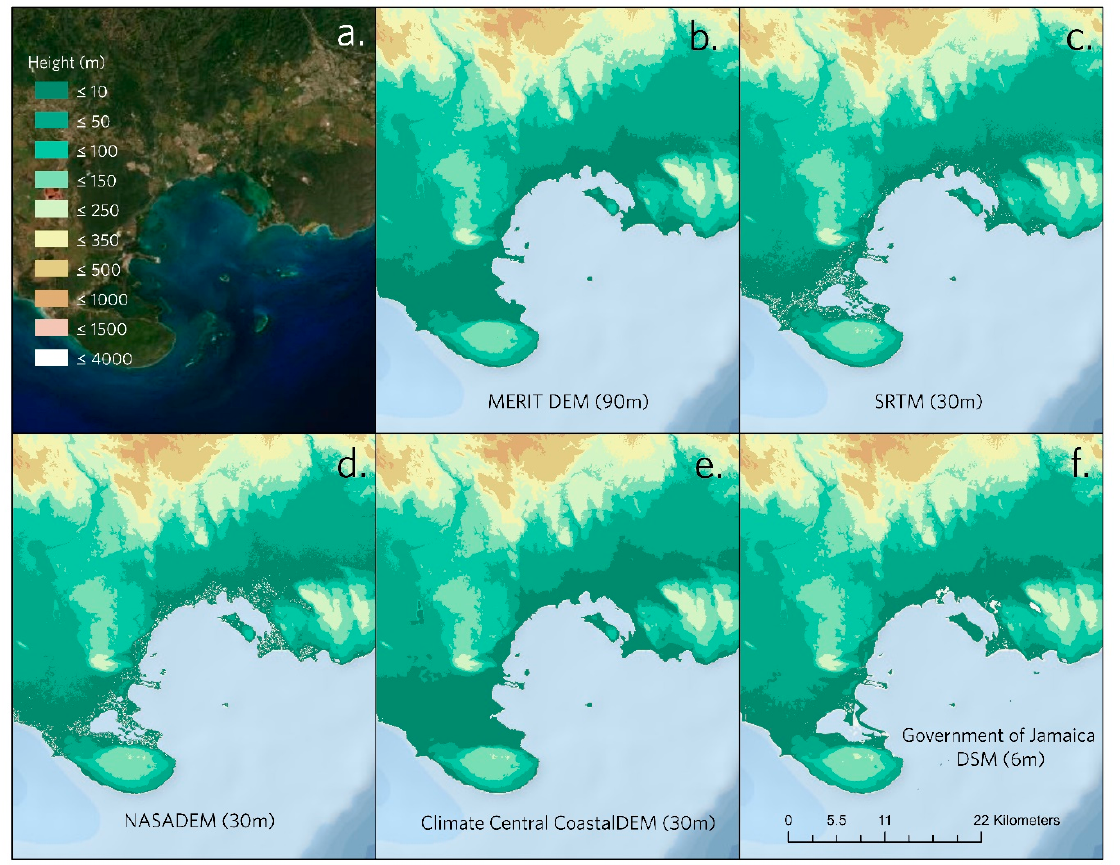
Figure 5. Comparison of elevation products of Old Harbour Bay, Jamaica. ( a ) Satellite image showing Old Harbour Bay; ( b ) MERIT DEM; ( c ) SRTM; ( d ) NASADEM; ( e ) CoastalDEM; and ( f ) Government of Jamaica digital surface model (DSM).